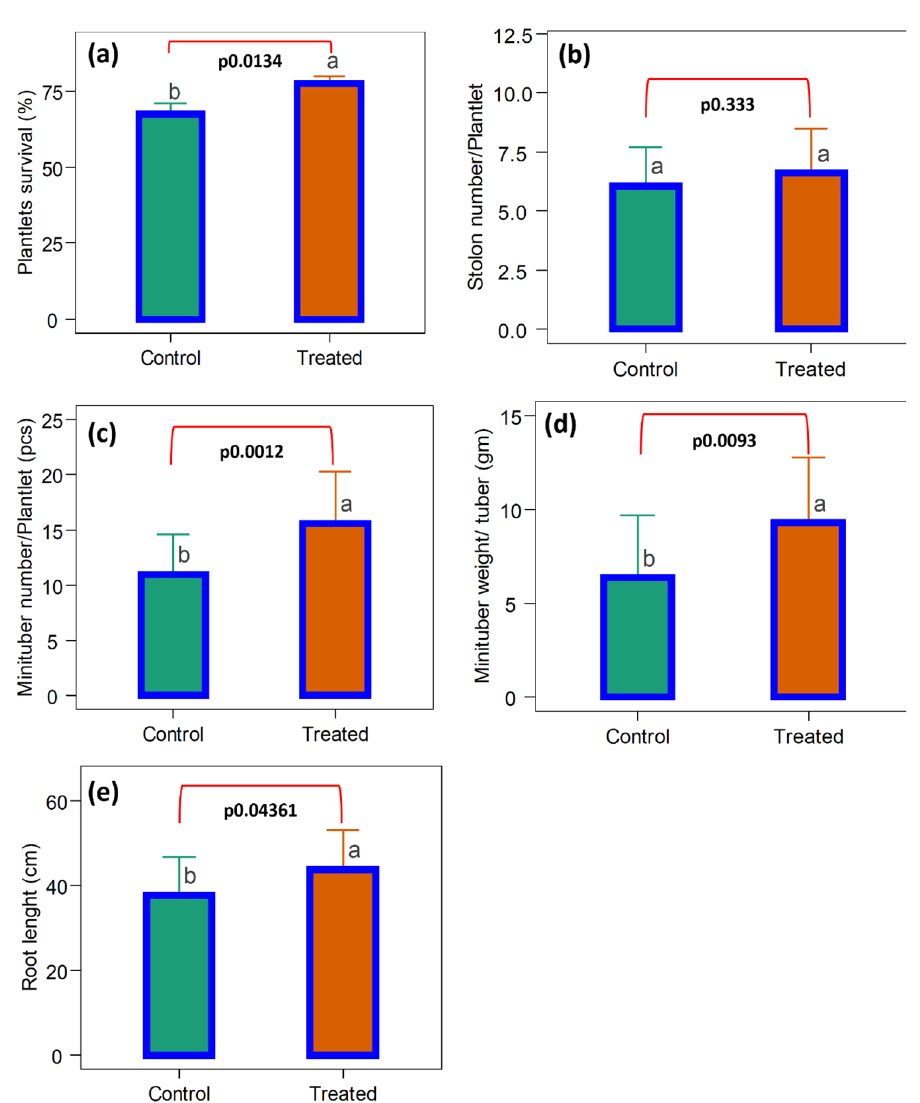
Figure 5. The effects of CW-S on minituber production in aeroponic. ( a ) Plantlet survival rate after transplantation in aeroponic. ( b ) Stolon number. c ) Minituber number. ( d ) Minituber weight. ( e ) Root length. Bars without shared letters indicate significant differences between the control and treated